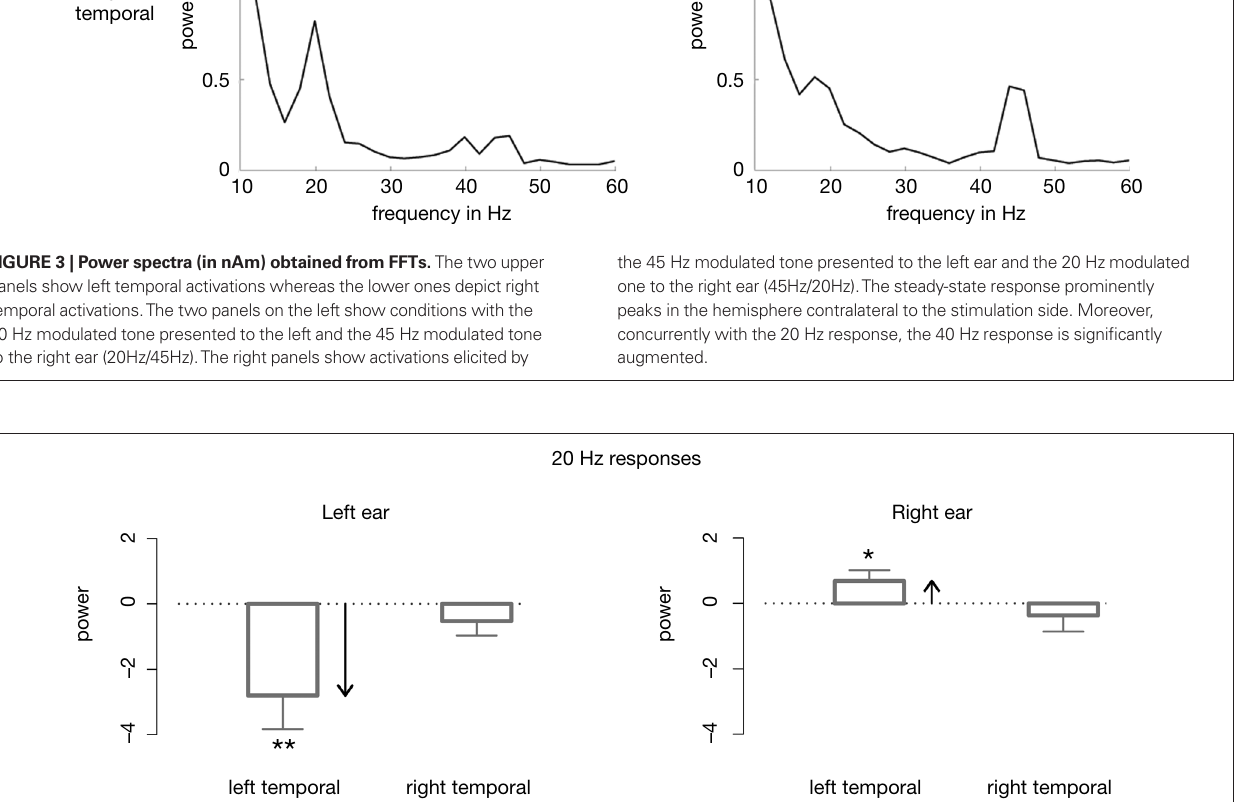
amplitude is enhanced in the left hemisphere. For a left cue, however, the left temporal 20 Hz responses are reduced. In the right hemisphere no differences due to attention could be